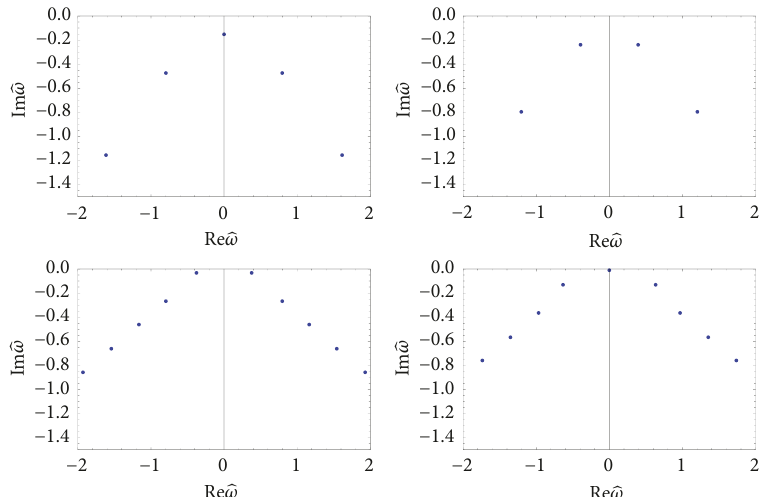
Figure 5: QNMs (blue spots) of the gauge mode for |𝛾 1 | = 0.02 (the panels above are for 𝛾 1 = −0.02 and the ones below for 𝛾 1 = 0.02 ) and ̂𝛼 = 0 . The left panels are the QNMs of the gauge mode and the right ones are that of the dual gauge mode.